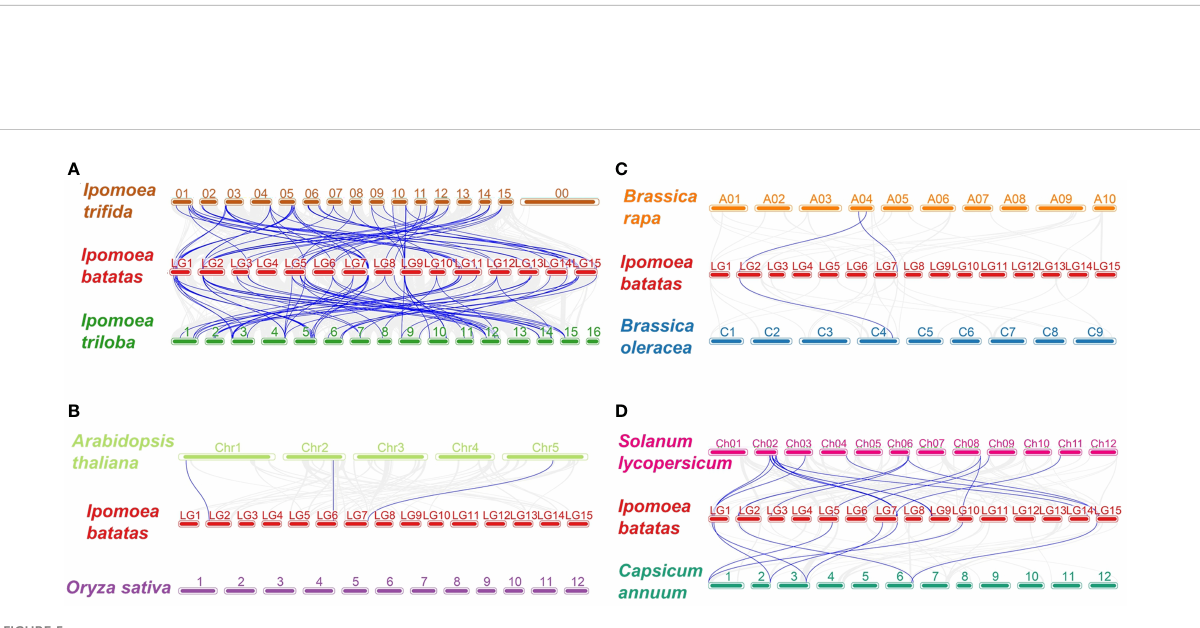
FIGURE 5 Synteny analyses of Dof genes between sweetpotato and eight representative plant species. (A) Ipomoea tri fi da and Ipomoea triloba , (B) Arabidopsis thalianaa and Oryza sativa , (C) Brassica rapa and Brassica oleracea , (D) Solanum lycopersicum and Capsicum annuum . The chromosomes of different plants are distinguished with differential colors. The blue lines connecting two different chromosomes highlight the syntenic Dof gene pairs within sweetpotato and other plant